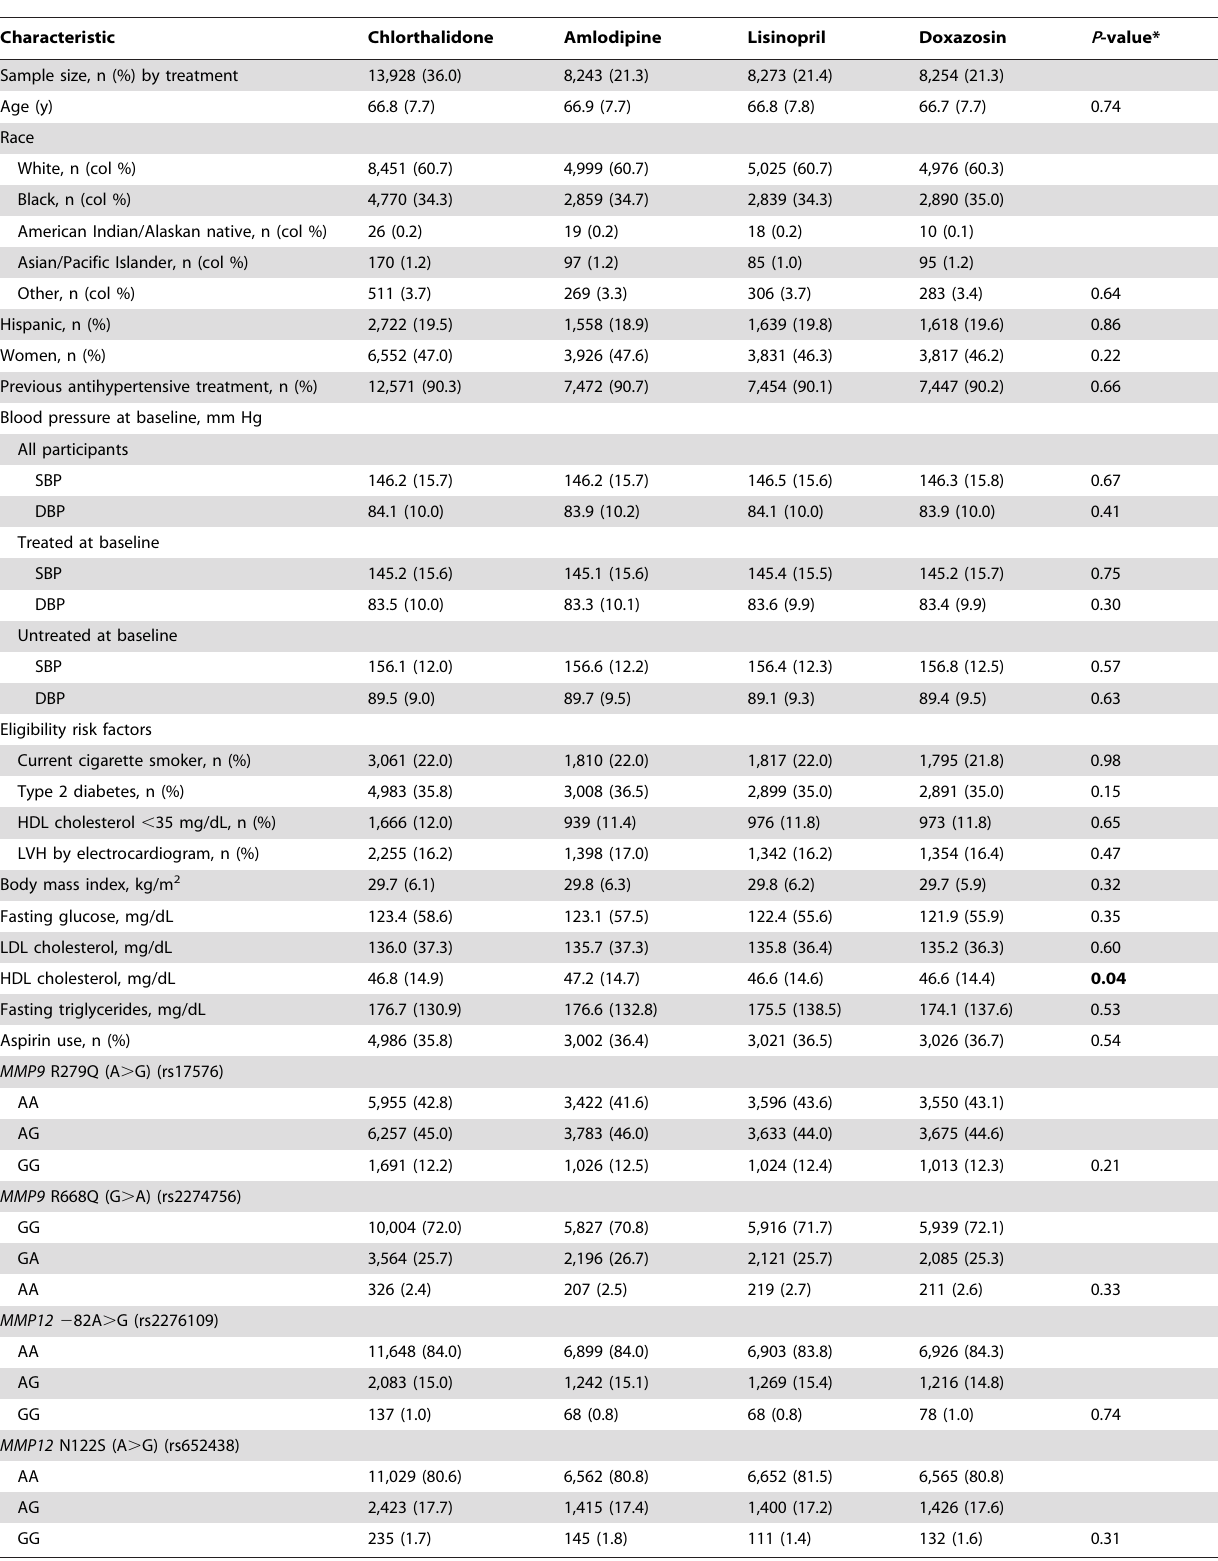
Table 1. Baseline characteristics for participants (n=38,698) by treatment group, mean (SD) unless otherwise noted.